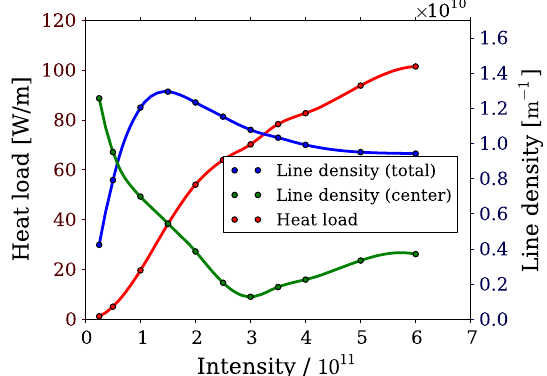
FIG. 4. The saturated electron cloud line density (blue) and heat FIG. 5. The saturated electron cloud line density (blue) and load (red) against the intensity in the absence of magnetic fields. heat load (red) against the bunch population in the presence of The dashed grey line shows the intensity at which the energy gain external dipole magnetic field. The SEY is chosen as δ of the sheath electrons is W The green curve represents the line density corresponding to the [Eq. (11)]. The SEY is chosen SEY ; max ¼ 1 . 4 . The green curve represents the line density diluted part of the cloud. as δ max corresponding to the diluted part of the cloud.